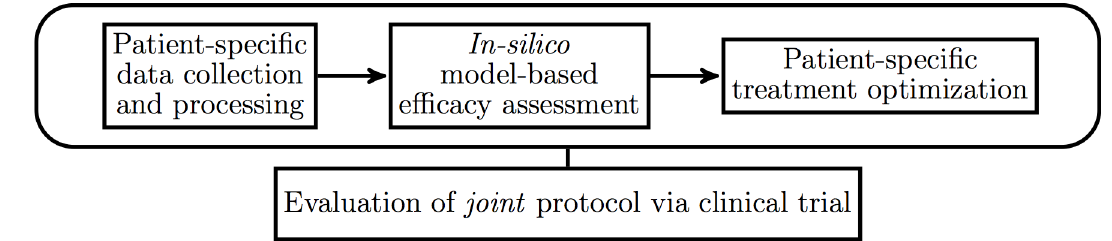
Fig 5. Precision medicine trials. Our proposed clinical trial framework for precision medicine consists of selecting a data collection, processing and model-based decision-making protocol, then testing the entire joint protocol in a classical trial setting.